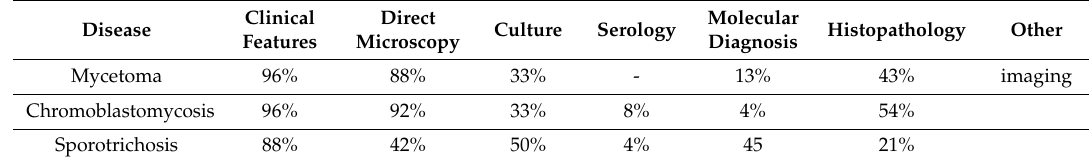
Table 2. Diagnostic methods of use in peripheral clinics and laboratories (positive results).